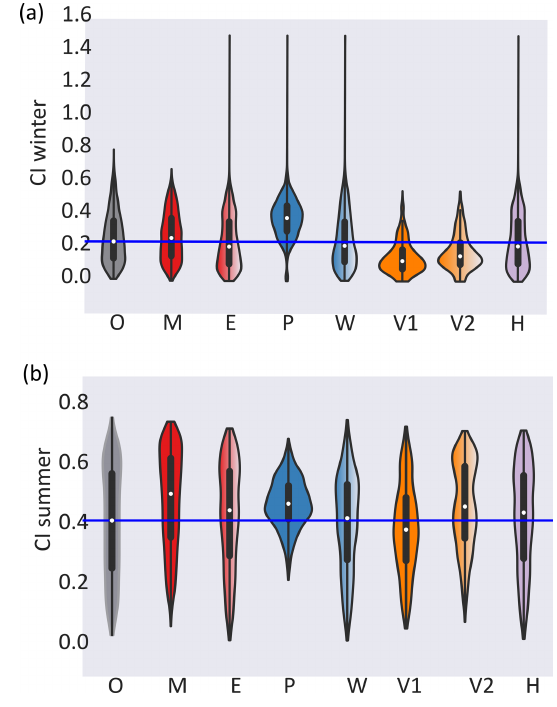
Figure 8. Mean daily clearness index (CI) during winter (a) and summer (b) is depicted in violin plots, where the kernel density dis- tribution of the observations and each model is shown, mirrored across the y axis. The observed median value is drawn with a blue solid